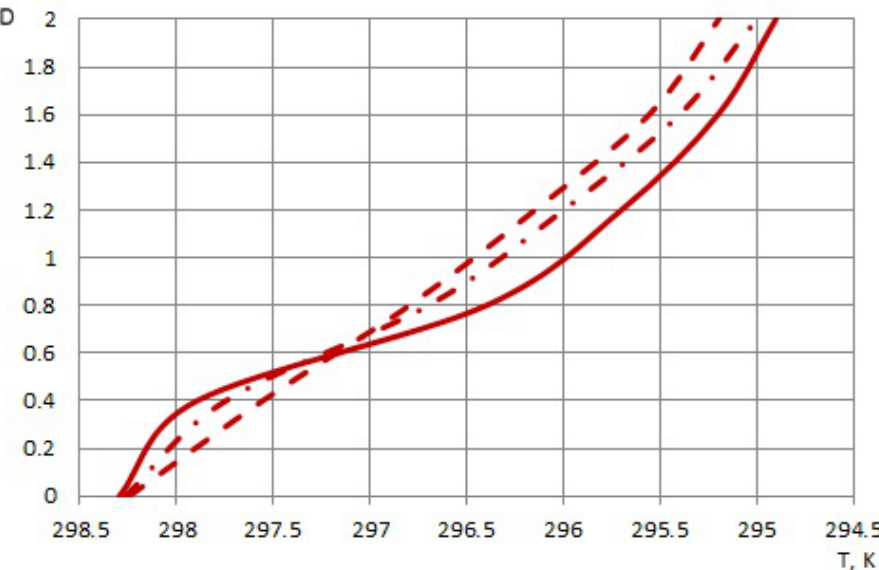
Figure 11. Temperature stratification of the boundary layer in the wind turbine zone: solid line— without wind turbine; dotted line—temperature stratification at a distance D = 4 from the mast of the wind turbine; dot-dash line—temperature stratification at a distance D = 8 from the mast of the wind